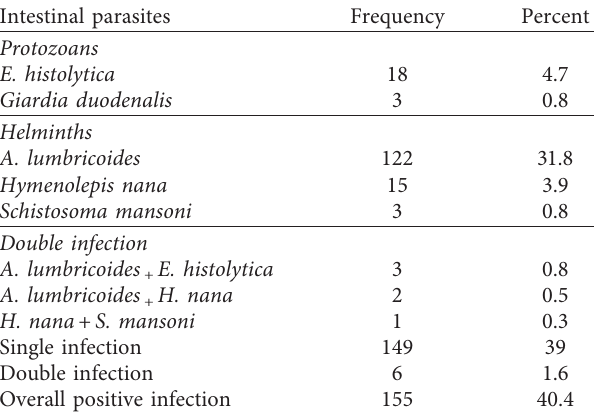
Table 2: The prevalence of intestinal parasitic infections among Maksegnit grade school children,